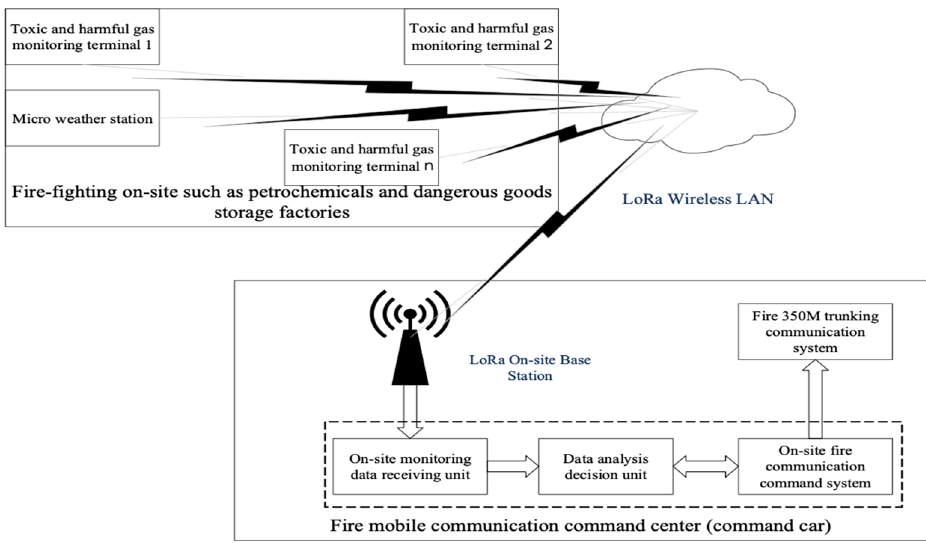
Figure 1. Schematic diagram of toxic and harmful gas monitoring system.